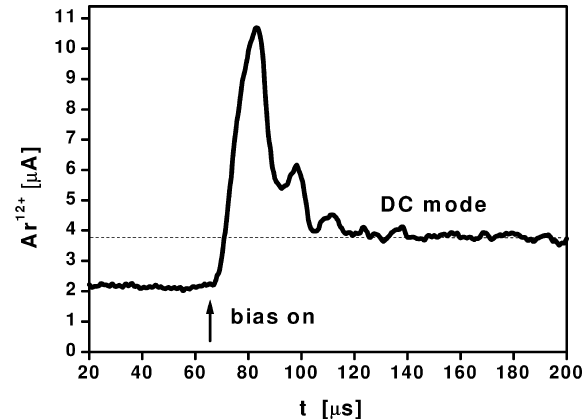
FIG. 7. Details of the time structure for a pulse of Ar 12 1 ions from an Ar (cid:1) O 2 (gas mixing) plasma. The argon and oxygen partial pressures were optimized to produce the maximum pulse